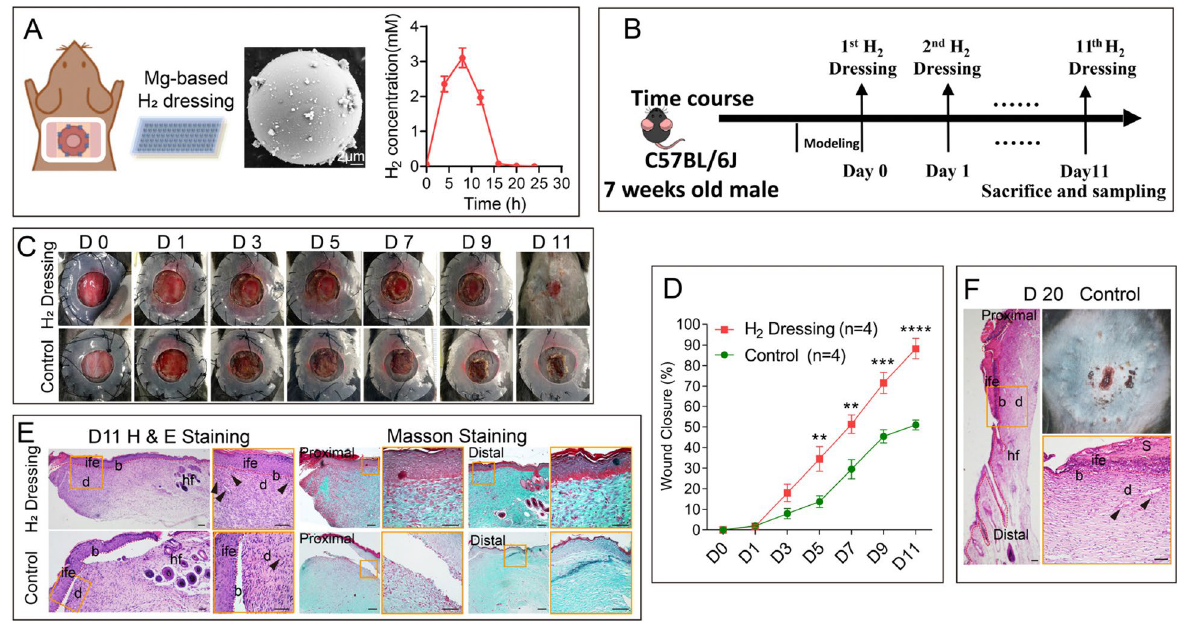
Fig. 6 Daily topical treatment of H 2 dressing significantly promoted cutaneous wound healing. A Left: scheme images of Mg-based H 2 dressing in cutaneous wound healing treatment; Middle: scanning electron microscope (SEM) image of Mg microparticles; right: H 2 release curves of Mg-based dressing. B Timeline of animal experiments and daily H 2 dressing treatment (or normal dressing condition). C Representative wound area images captured every 2 days after modeling. D Comparison of wound closure percentage after modeling between H 2 dressing and control groups. E , F H&E staining and Masson staining showing the tissue remodeling 11 days and 20 days post-wounding. Data in D was analyzed by two-way ANOVA test. All of the data are plotted as mean SEM. * P value < 0.05; ** P value < 0.01; *** P value < 0.001; **** P value < 0.0001; no stars for P value > 0.05; ± scale bar in